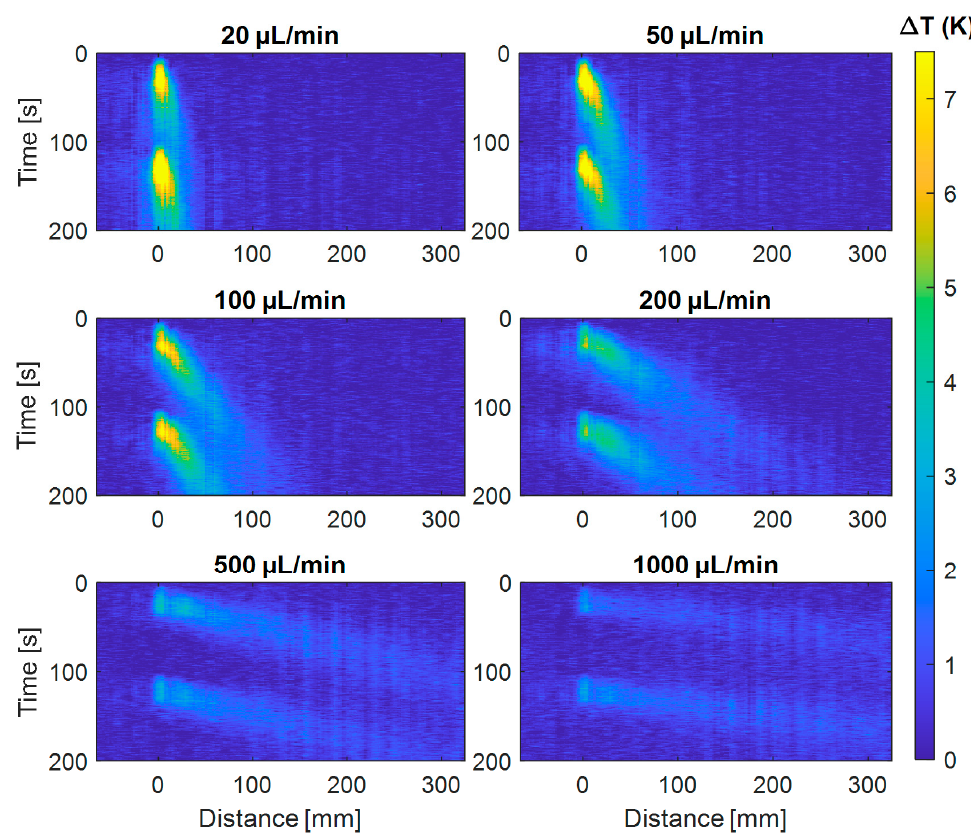
Figure 4. Propagation of the heating pulses induced in water at a fixed fiber position (indicated at a distance of 0 mm) as a function of time and distance for different flow rates. Two heating pulses are injected during 30 s and separated by a 70 s waiting period. The convective heat transport by the flow is clearly observable for the different flows. The color bar indicates the measured temperature increase ∆𝑇 (in Kelvin) of the water, which for low flow rates reaches up to ≈ 7 K above room temperature.